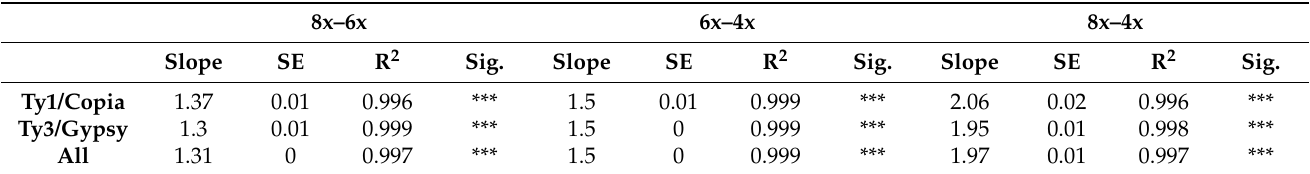
Figure 4. Pairwise scatterplot comparisons of the number of reads included in repeat clusters from each cytotype. The slope indicates the genome size ratio between each cytotype. ( A ) 4x vs. 6x. ( B ) 4x vs. 8x. ( C ) 8x vs. 6x. Table 2. Statistics for the linear regression analyses carried out between cytotype pairs based on an analysis of the number of reads of Ty1/Copia-like elements, Ty3/Gypsy-like elements, and all repetitive elements (All). (SE: Standard error, Sig.: *** p -value < 0.0001).